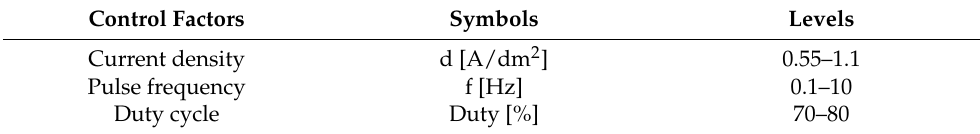
Table 5. Control factors and their levels.